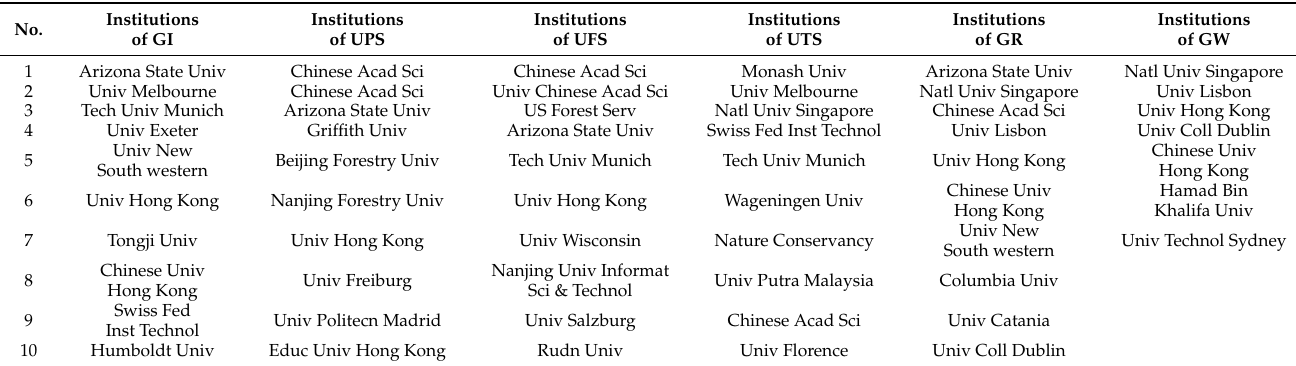
Table 3. Top 10 institutions by publications in different GI types,